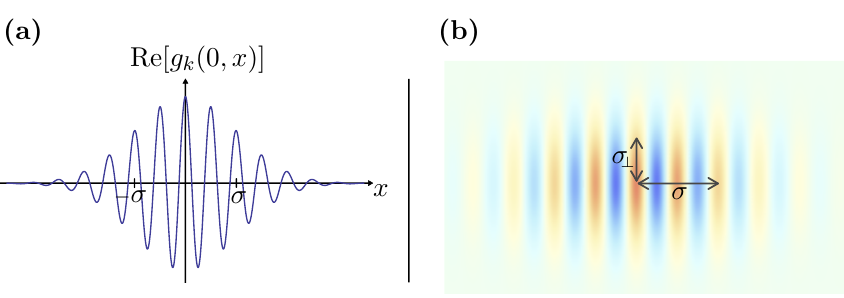
Figure 2 . Schematic depiction of: the real part of (a) the 1+1 dimensional Minkowski wavepacket (arbitrary units on the vertical axis), and (b) a slice of the D -dimensional Minkowski wavepacket. For the plots, we have set k = 4 (cid:25)=(cid:27) and (cid:27) = (cid:27)= ?